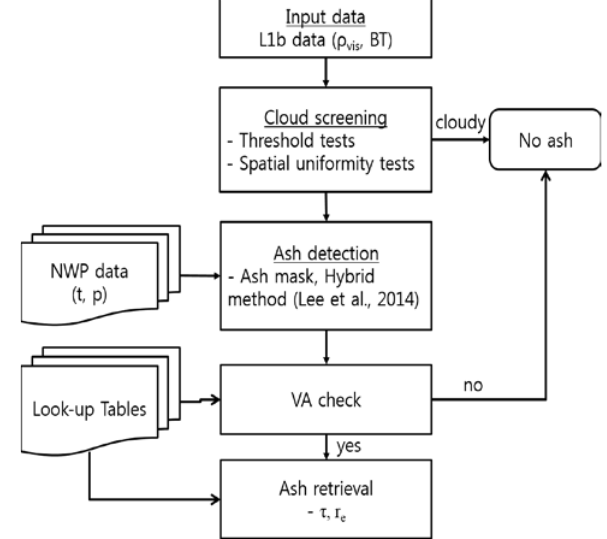
Figure 3. Flowchart of the AMI VA algorithm.